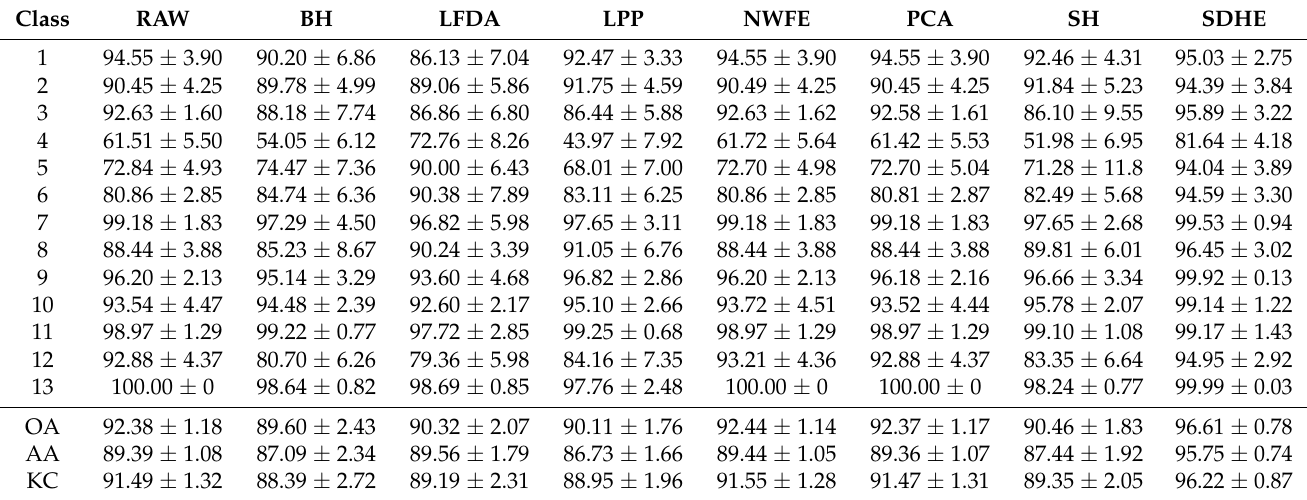
Table 6. Classification accuracy (%) at 30-dimensionality for KSC with the training set of 20 samples per